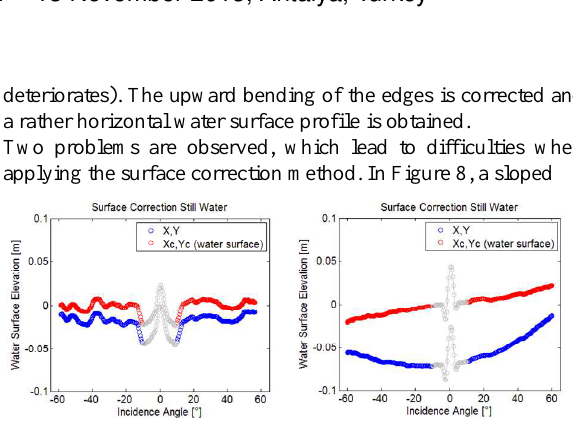
Figure 8: Unequally distributed Kaolinit (left) and aslope TLS installation (right)